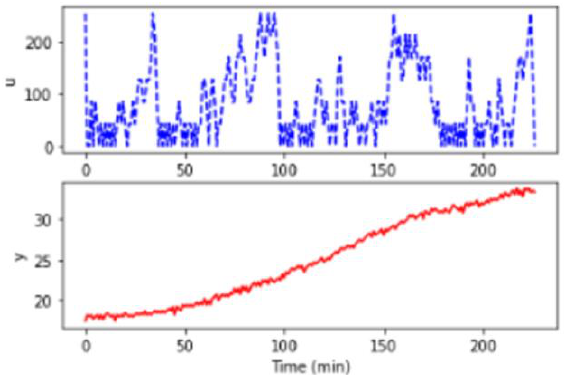
Figure 5. IoT-based control system measured input/output data.